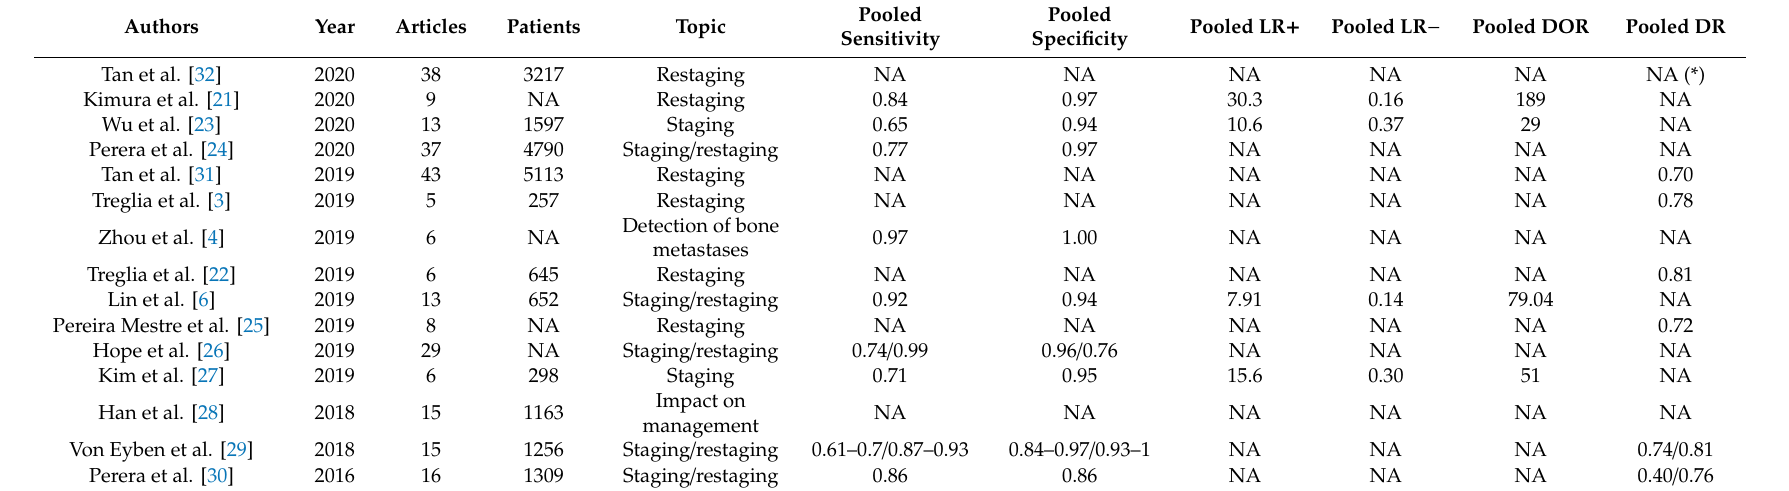
Table 2. Meta-analyses on PET / CT with PSMA-targeted agents in prostate cancer.